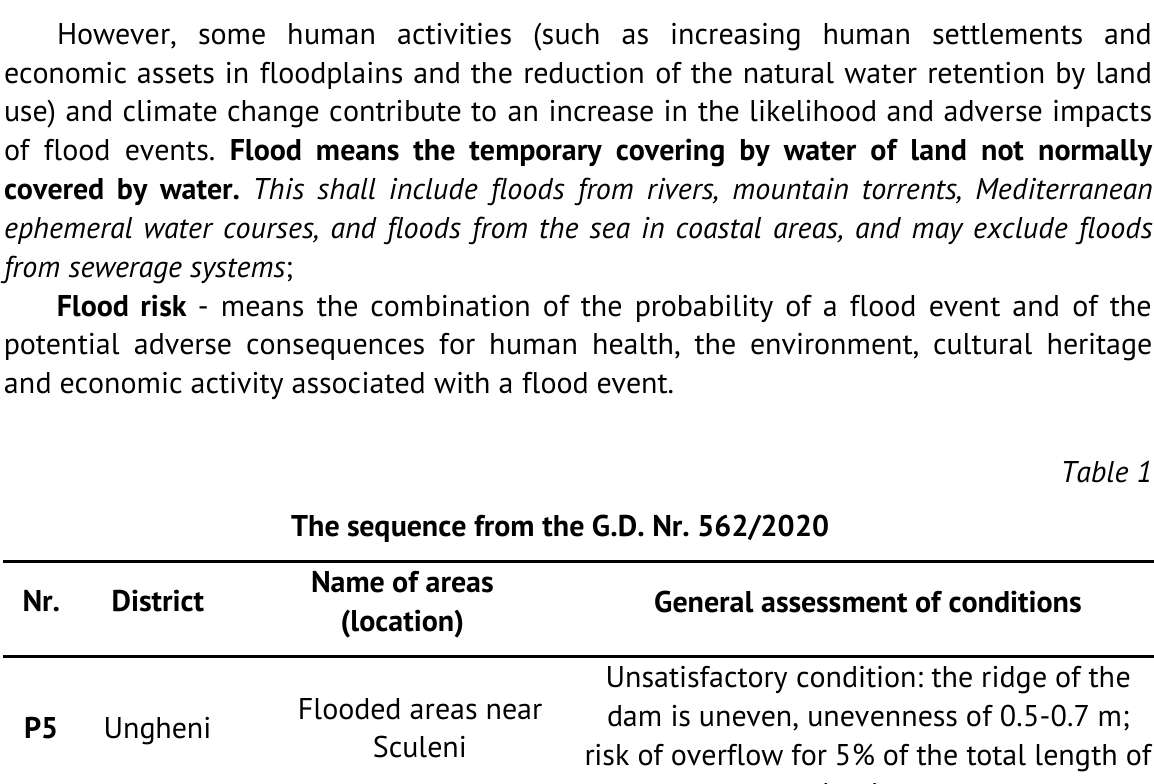
Figure 1. Hydrographic basin districts of RM